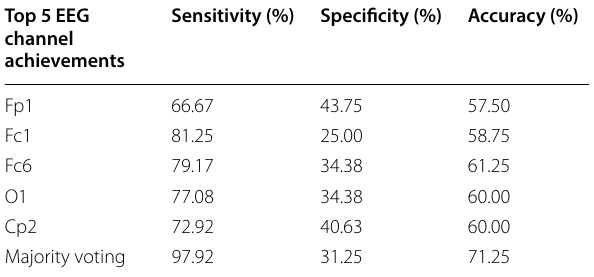
Table 7 Top 5 EEG channel achievements on alpha rhythm for HA vs LA classification Top 5 EEG channel